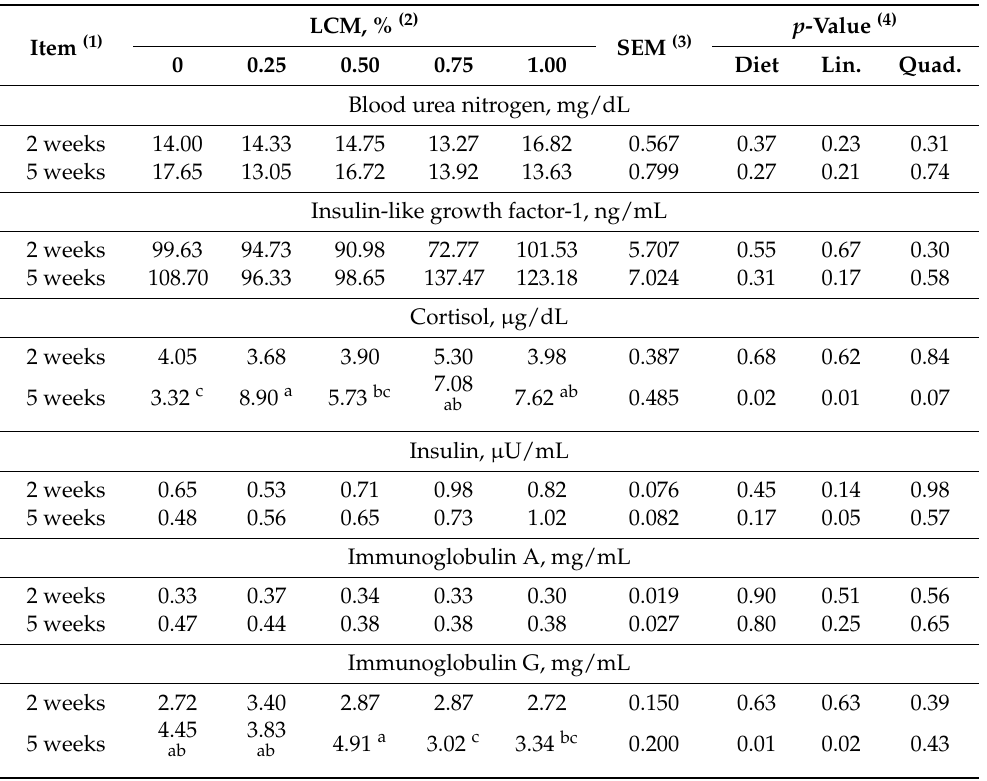
Table 8. Effects of LCM supplementation levels on blood profiles in weaning pigs (exp.